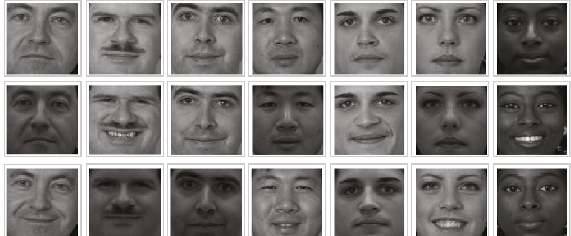
Figure 12: Example FERET images used in our experiments (cropped to the size of 128 × 128 to extract the facial region). The figure shows in the top two rows the examples of training images used in our experiments and in the bottom row the examples of test images.